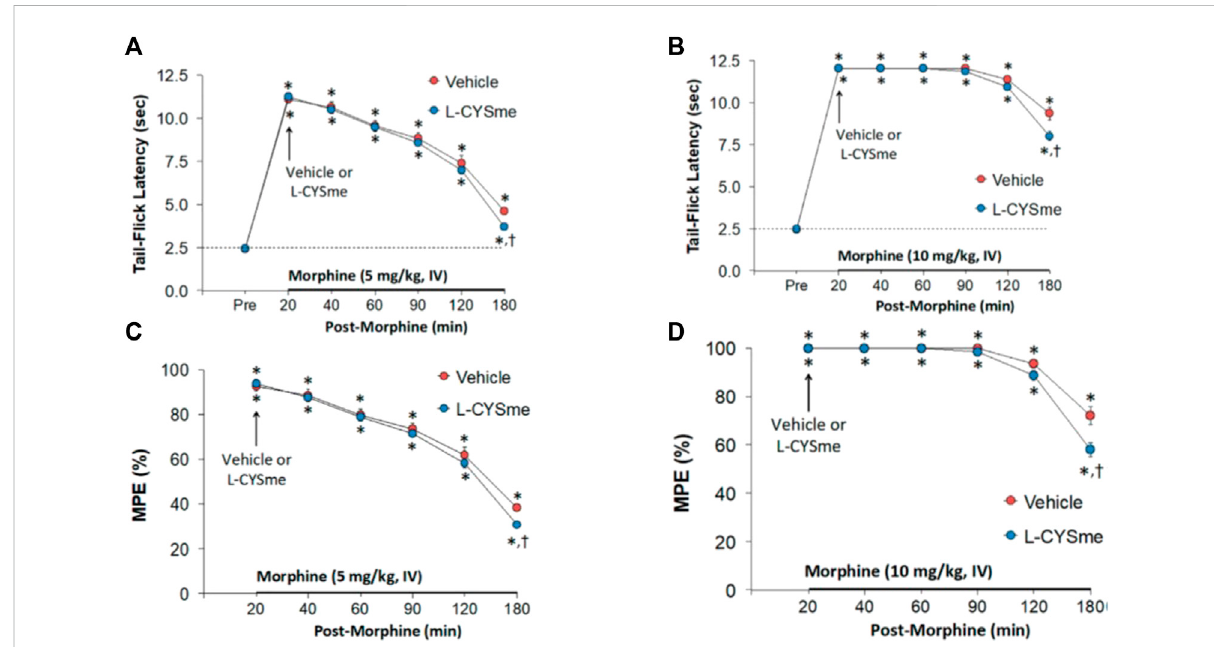
FIGURE 12 Changes in tail- fl ick latency values elicited by an intravenous injection of vehicle (VEH, saline) or L-cysteine methyl ester (L-CYSme, 500 μ mol/kg, IV) given 20 min after the injection of morphine at 5 mg/kg Panel (A) or 10 mg/kg Panel (B) in freely-moving rats. Panels (C,D) display thedataasmaximumpossibleeffect(%MPE).Thedataareshownasmean±SEM.Therewere6ratsineachgroup.* p < 0.05,signi fi cantchangefrom Pre. † p < 0.05, signi fi cant change between L-CYSme versus